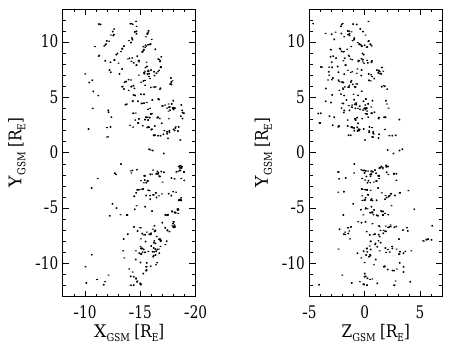
Figure 4. Spatial distribution of 466DF events in the XY and YZ